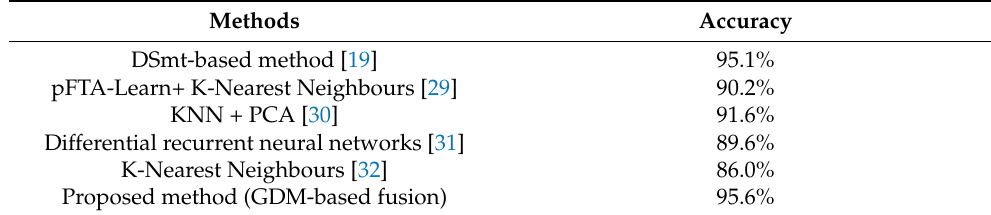
Table 6. The performance comparison of different fusion strategies for four subjects in DSAD da- taset. Table 7. Comparison with some state-of-the-art HAR approaches based on DSAD dataset.